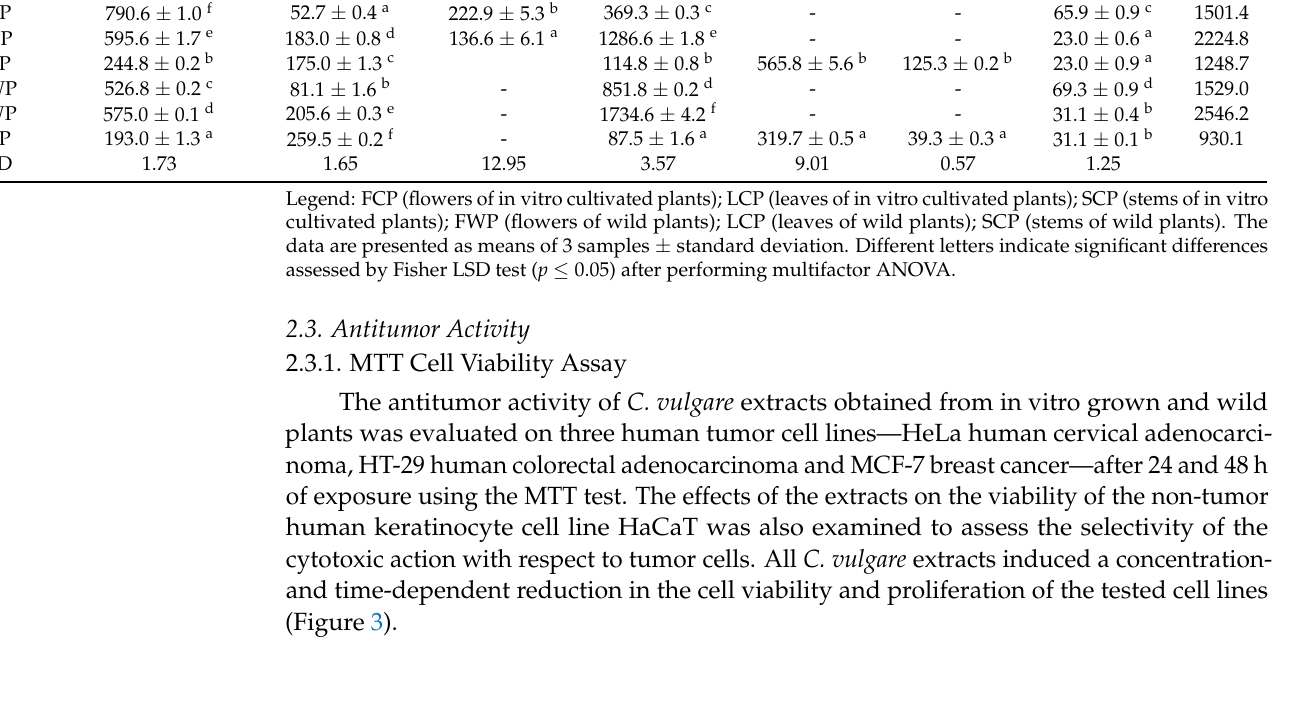
Table 3. Phenolic constituents (mg/100 g DW) of in vitro cultivated and wild-growing C. vulgare plants. Neochlorogenic Samples